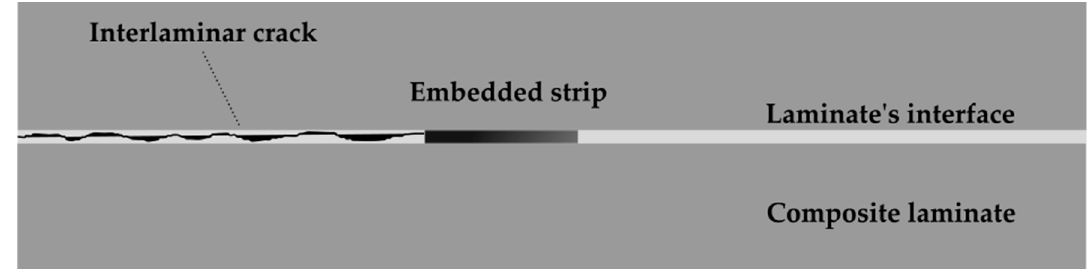
Figure 13. Transverse butt-joined elements as CAF in skin-stiffener structure [85].